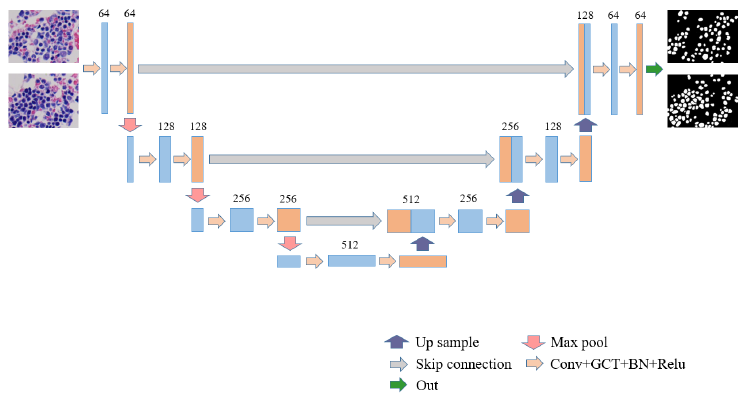
Figure 2. The structure of our proposed